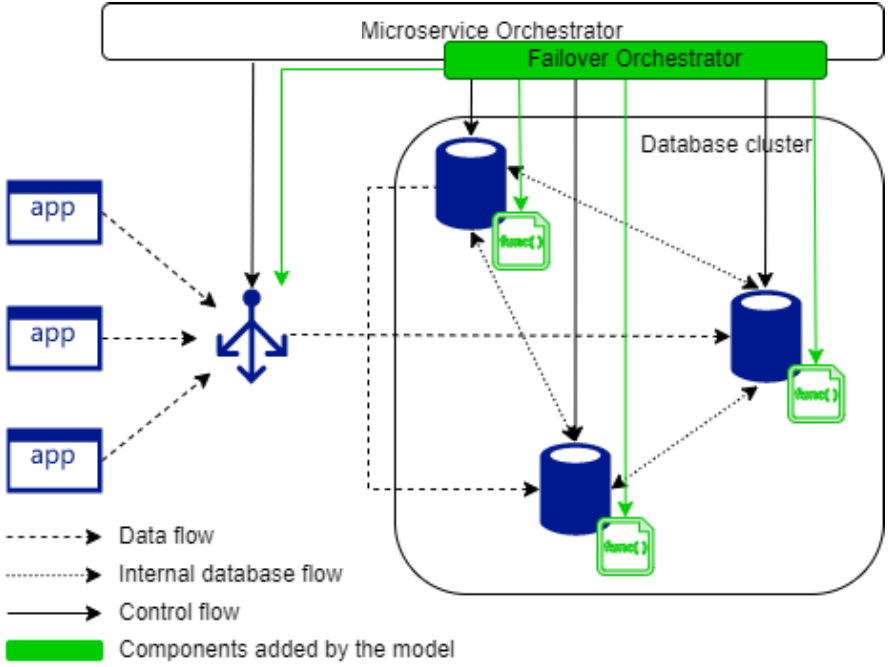
Figure 3. Components of the proposed method.